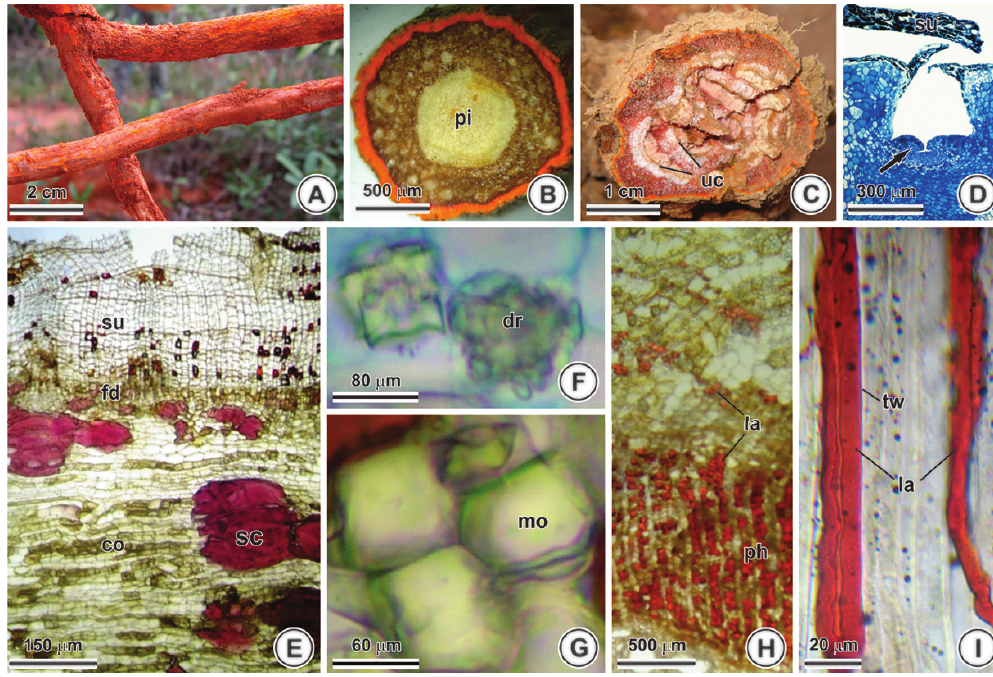
Figure 1 - Underground stem of Tontelea micrantha . (A-C) General aspect, showing its natural orange coloration (presence of carotenoids). (D-G) Transverse sections. (I) Longitudinal section. (B) Stem-like structure (presence of pith). (C) Unusual cambial activity. (D) Adventitious bud (arrow). Periderm and cortex. (F) Druses. (G) Mono-crystals. (H-I) Laticifers in the secondary phloem. co: cortex; dr: druse; fd: phelloderm; la: laticifer; pi: pith; mo: mono-crystal; sc: sclereid; su: suber; tw; thick wall; uc: unusual